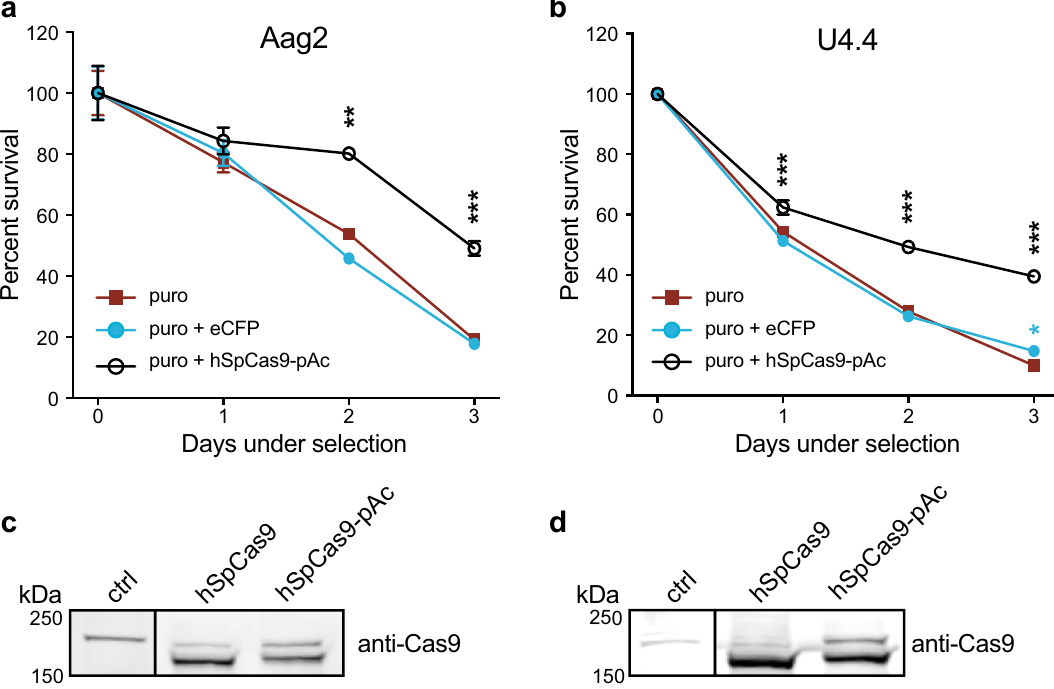
Figure 2. Efficient puromycin selection of mosquito cells transfected with hSpCas9-pAc. ( a ) Aag2 cells were pre-treated with transfection reagent alone (puro), transfected with a control PUb-eCFP (enhanced cyan fluorescent protein) plasmid lacking a puromycin (puro) resistance cassette (puro + eCFP), or transfected with PUb-hSpCas9 linked to a puro resistance cassette by the T2A skipping site (hSpCas9-pAc). Day 2 post-transfection, cells were treated with 2.5 µg/mL puro. p < 0.0001 (overall ANOVA comparing different transfections); individual groups were compared using the Dunnett’s post hoc test compared to the puro control; ** p < 0.001, *** p ≤ 0.0001. ( b ) As in ( a ) for U4.4 cells treated with 10 µg/mL puro. * p < 0.05, *** p ≤ 0.0001. ( c ) Immunoblot of Aag2 cells treated with transfection reagent alone (ctrl) or transfected with hSpCas9 or hSpCas9-pAc (driven by PUb promoter). Expected size of hSpCas9 is ~ 160 kilodaltons (kDa); expected size of unprocessed hSpCas9-pAc is ~ 185 kDa. Full-length blots in Supplementary Fig. 4. ( d ) As in ( c ) for U4.4